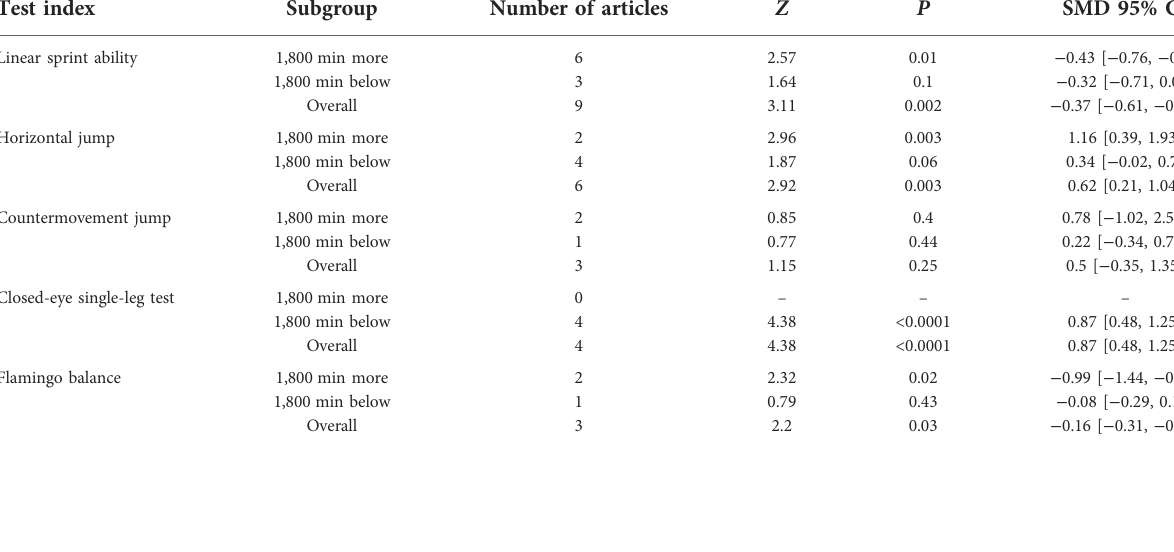
TABLE 3 Comparison of the effects of different total intervention times.